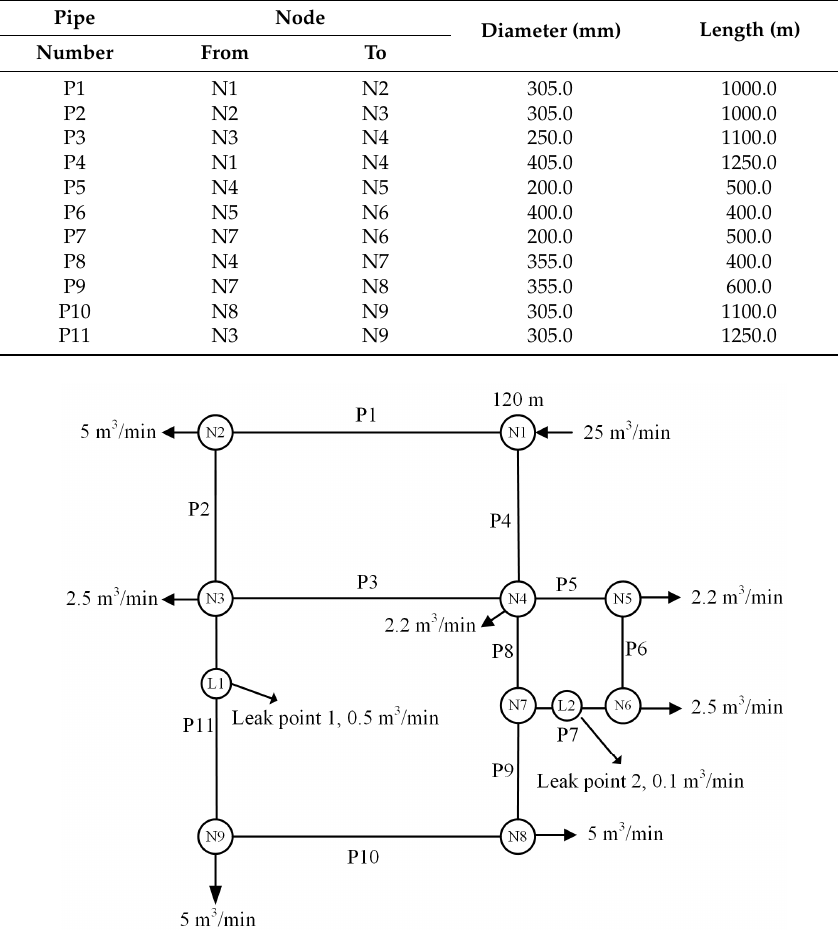
Table 2. The characteristics of the synthetic pipe network B.